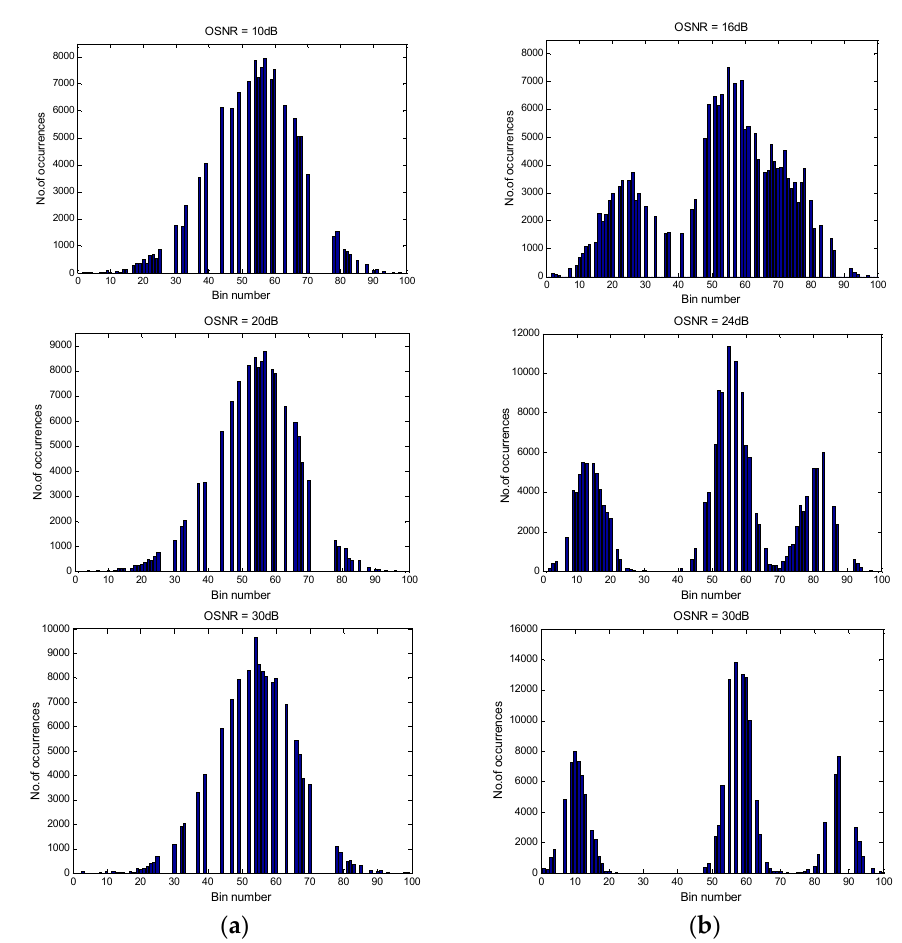
Figure 9. The sparse amplitude histogram of ( a ) PM-RZ-QPSK signal and ( b ) PM-NRZ-16QAM signal obtained by IBPSO.